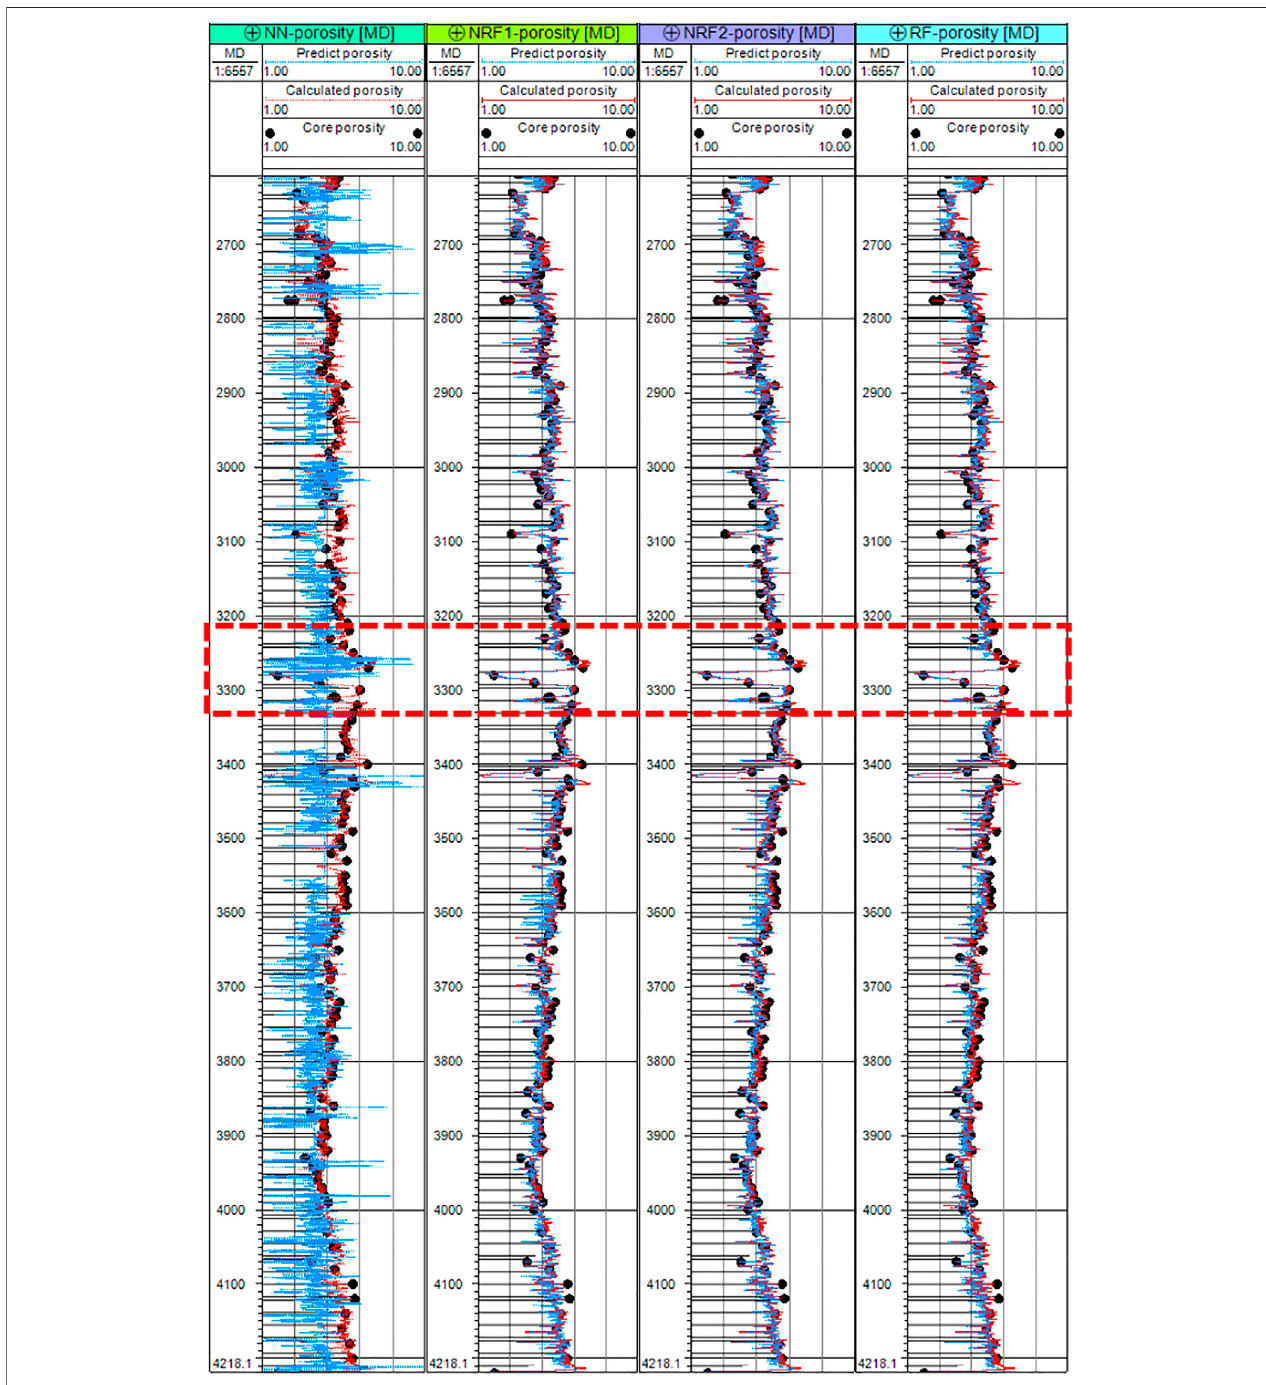
FIGURE 5 | Comparison between actual and predicted porosity data in different models